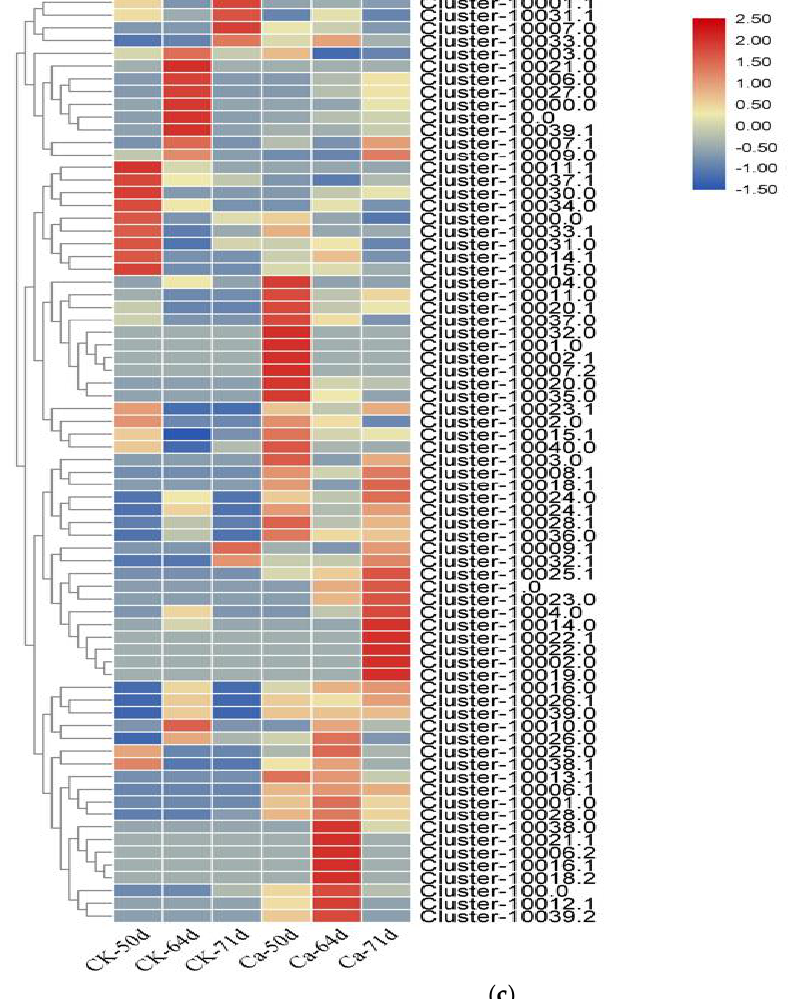
Figure 7. Statistics and cluster heatmap of differentially expressed genes involved in specific metabolic pathways: ( a ) metabolic pathway of starch and sucrose metabolism; ( b ) flavonoid biosynthesis pathway; ( c ) starch and sucrose metabolism pathway.